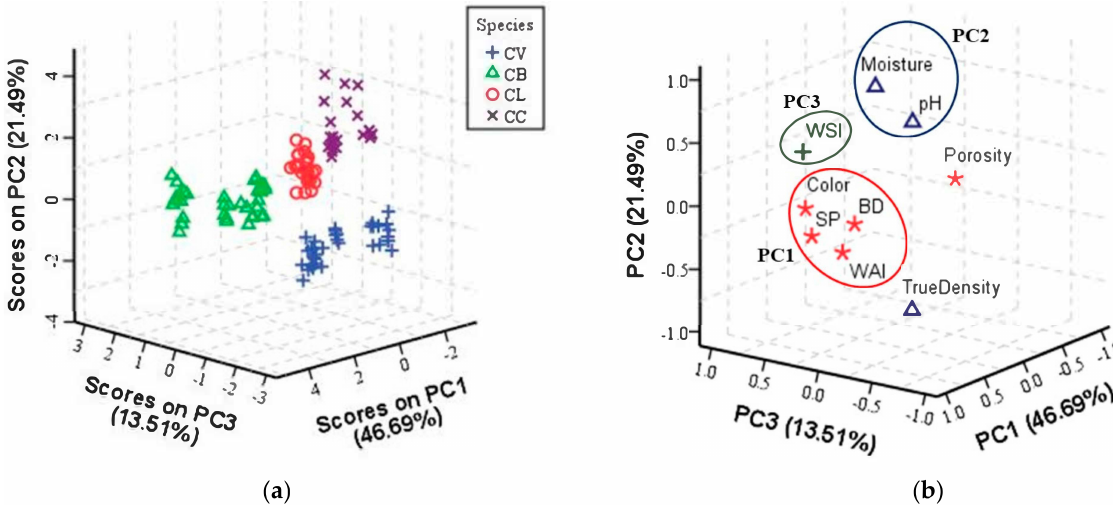
Figure 1. PCA plots of Cinnamomum species based on nine physico-functional variables: ( a ) 3-D score plot and ( b ) corre- sponding loading plot showing positively (with circles) and negatively (without circles) correlated variables. CV: C . verum ; CB: C . burmannii ; CL: C . loureiroi ; CC: C . cassia ; BD: bulk density; WAI: water absorption index; WSI: water solubility index; SP: swelling